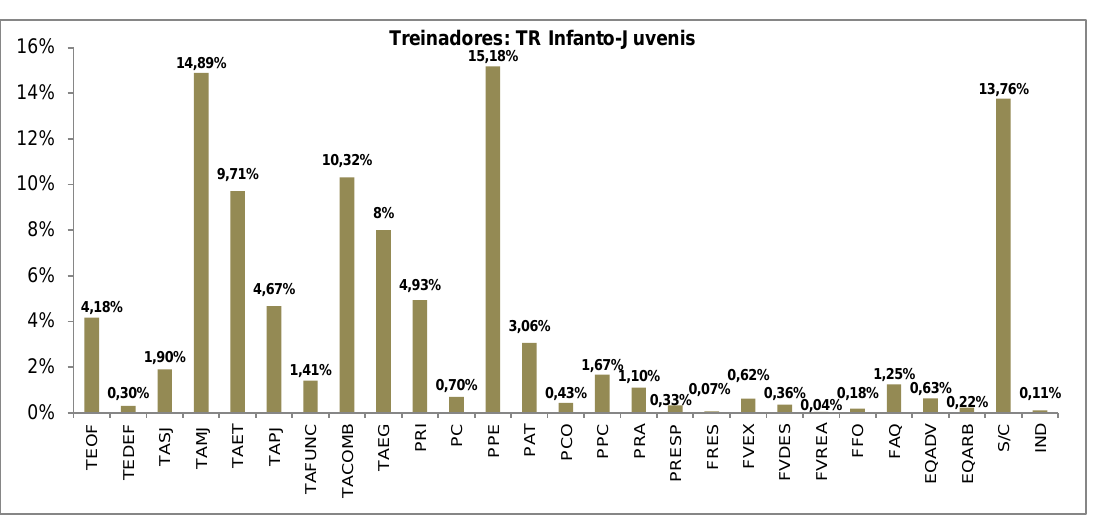
Figura 2. Valores em porcentagem das categorias/subcategorias da dimensão conteúdo durante a competição (TEOF – Técnicas Ofensivas; TEDEF – Técnicas Defensivas; TASJ – Tática de Sistema de Jogo; TAMJ – Tática de Método de Jogo; TAET – Tática dos Esquemas Táticos; TAPJ – Tática dos Principios de Jogo; TAFUNC – Táctica